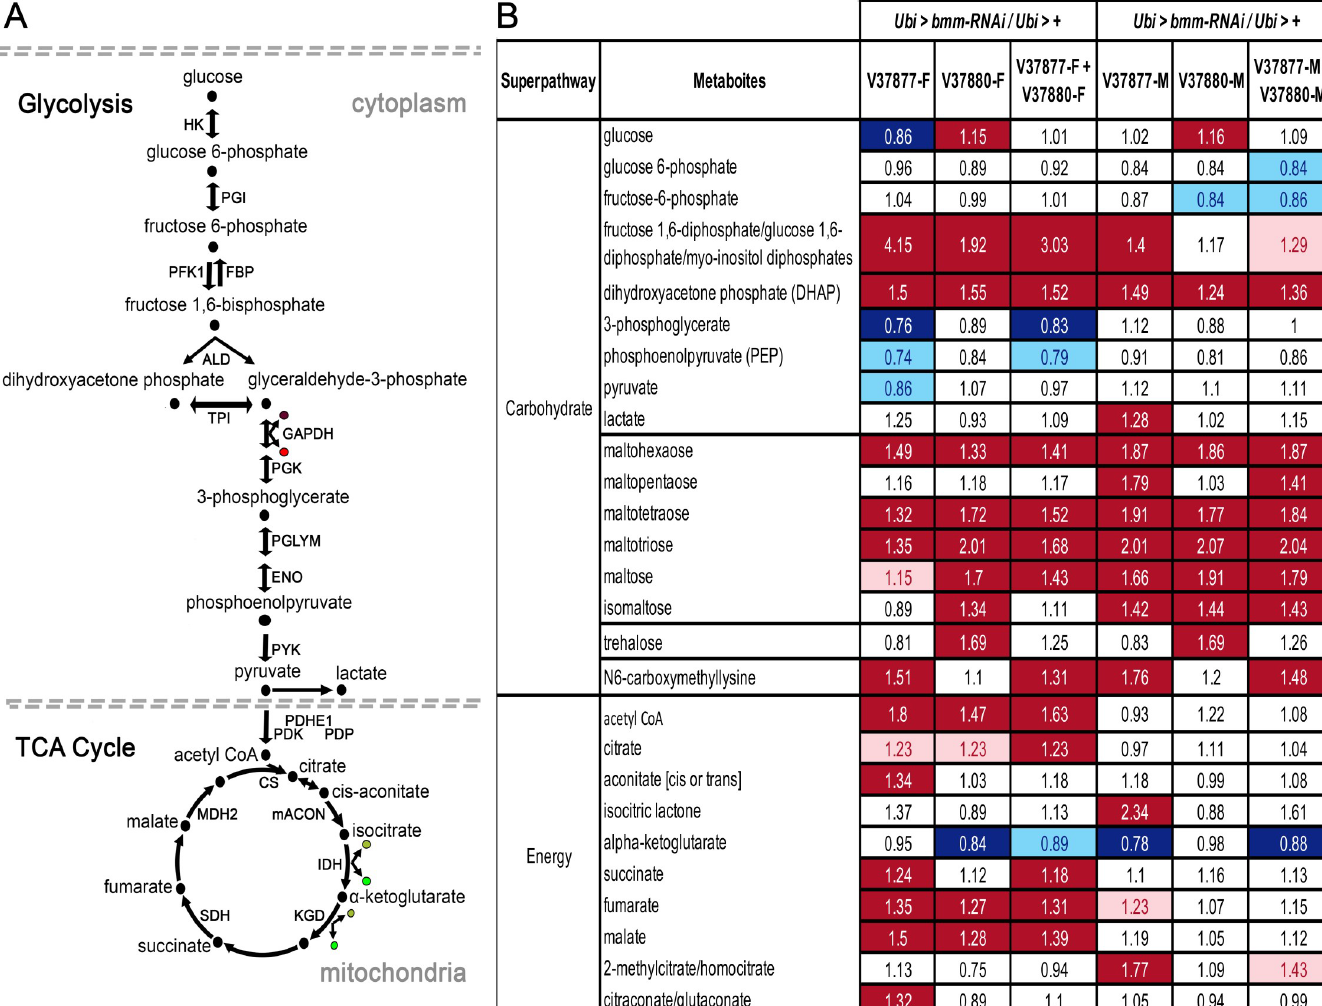
Fig 7. Metabolites of glycolysis and the TCA cycle with altered abundance levels in Ubi > bmm-RNAi flies. (a) Diagram of the glycolysis pathway and the TCA cycle. Black dots represent intermediates in the pathways and the enzymes in the reactions are marked with arrows and their initials: HK = Hexokinase, PGI = Phosphoglucose isomerase, FBP = Fructose 1,6-biphosphatase, PFK = Phosphofructokinase, ALD = Aldolase, TPI = Triosephosphate isomerase, GAPDH = Glyceraldehyde-3-phosphate dehydrogenase, PGK = Phosphoglycerate kinase, PGLYM = Phosphoglyceromutase, ENO = Enolase, PYK = Pyruvate kinase, PDHE1 = Pyruvate dehydrogenase E1, PDK = Pyruvate dehydrogenase kinase, PDP = Pyruvate dehydrogenase phosphatase, CS = Citrate synthase, mACON = Mitochondrial aconitase, IDH = Isocitrate dehydrogenase, KGD = alpha-ketoglutarate dehydrogenase, SDH = Succinate dehydrogenase, MDH2 = Malate dehydrogenase. Brown dots designate ADP, bright-red dots, ATP, opaque-green dots, NAD+ and bright-green dots, NADH. (b) Heat map of variation in intermediates of carbohydrate metabolism and TCA cycle with altered abundance levels in bmm down-regulated ( Ubi > bmm-RNAi ) and control flies ( Ubi > +). Red and dark blue represent the metabolites that increased and decreased respectively at p � 0.05, light red and light blue represent the metabolites that increased and decreased respectively at 0.05 � p � 0.1 (q-value is reported in S1 Dataset). Asterisks indicate compounds that have not been confirmed based on a standard. https://doi.org/10.1371/journal.pone.0255198.g007 We also identified 76 metabolites from 9 nucleotide metabolism sub-pathways (S8 Fig). Ubi > bmm-RNAi V37877 flies showed more changes in levels of nucleotide intermediaries than Ubi > bmm-RNAi V37880 flies. In Ubi > bmm-RNAi V37877 females 65 metabolites underwent changes in abundance (58 " /7 # ), whereas only 39 metabolites changed (27 " /12 # ) in Ubi > bmm-RNAi V37880 females. In Ubi > bmm-RNAi V37877 males 64 metabolites showed altered lev- els of abundance (54 " /10 # ) and levels of 32 metabolites changed in Ubi > bmm-RNAi V37880